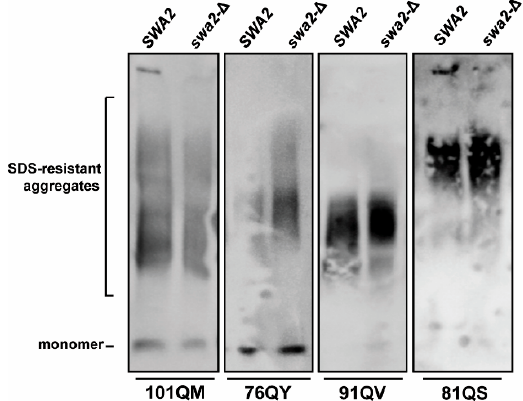
Figure 5. The JDP Swa2 is dispensable for the propagation of at least four polyQX prions. Haploid [ psi − ], [ pin − ] strains bearing four distinct polyQX prions were crossed to a [ psi − ], [ pin − ] strain bearing a deletion of the SWA2 gene ( swa2- ∆ ). Following sporulation and tetrad dissection, swa2- ∆ F1 haploids as well as F1 haploids which maintained the SWA2 gene were assayed for the maintenance of each polyQX prion by SDD-AGE followed by immunoblotting with Sup35 antibody. Representative examples are shown from n ≥ 5 in each case.